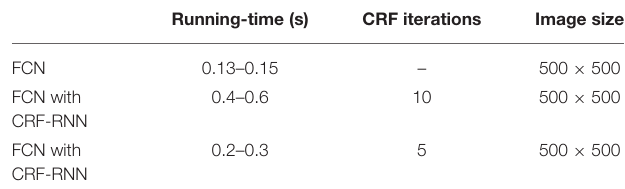
TABLE 5 | The running-time performance on the MINC dataset.